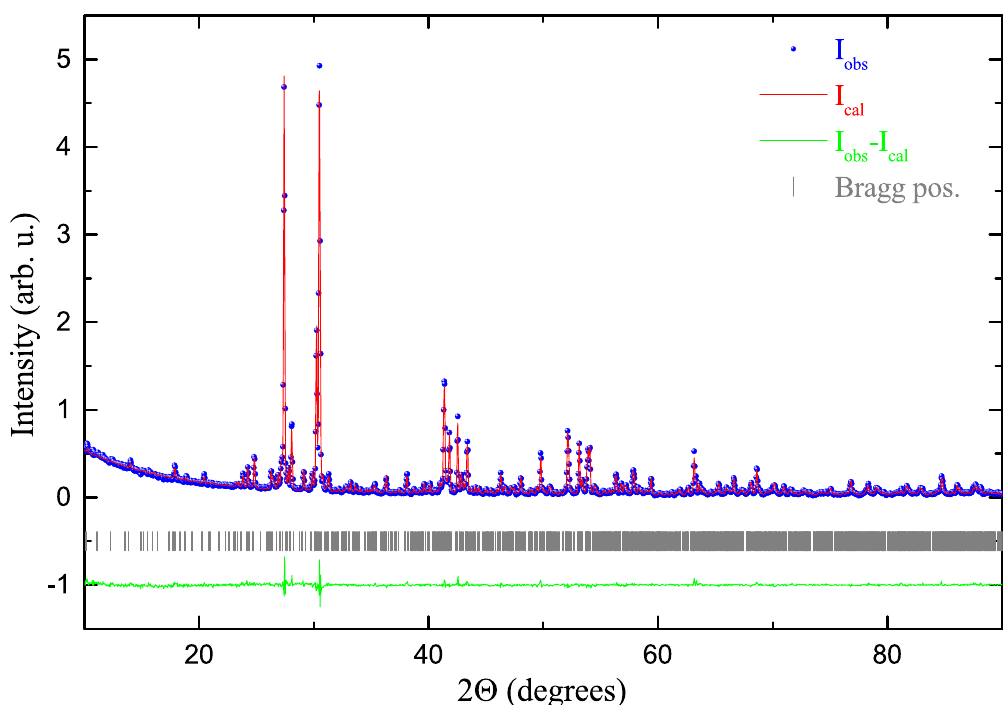
Figure 2. Powder X-ray diffraction pattern (Cu-K α ) of the grown Ba 26 Ru 12 O 57 single crystal collected 1 at room temperature. The red solid line represents a Rietveld fit based on the structure model obtained by single crystal X-ray diffraction (using the FullProf software package [18]). The calculated Bragg peak positions (according to space group Fdd2 ) are indicated by vertical bars and the difference between the experimental and calculated intensities are shown by the green solid line at the bottom. The obtained lattice parameters (space group Fdd2 ) amount to a = 20.4536(4) Å, b = 51.1908(8) Å and c = 11.7732(2)